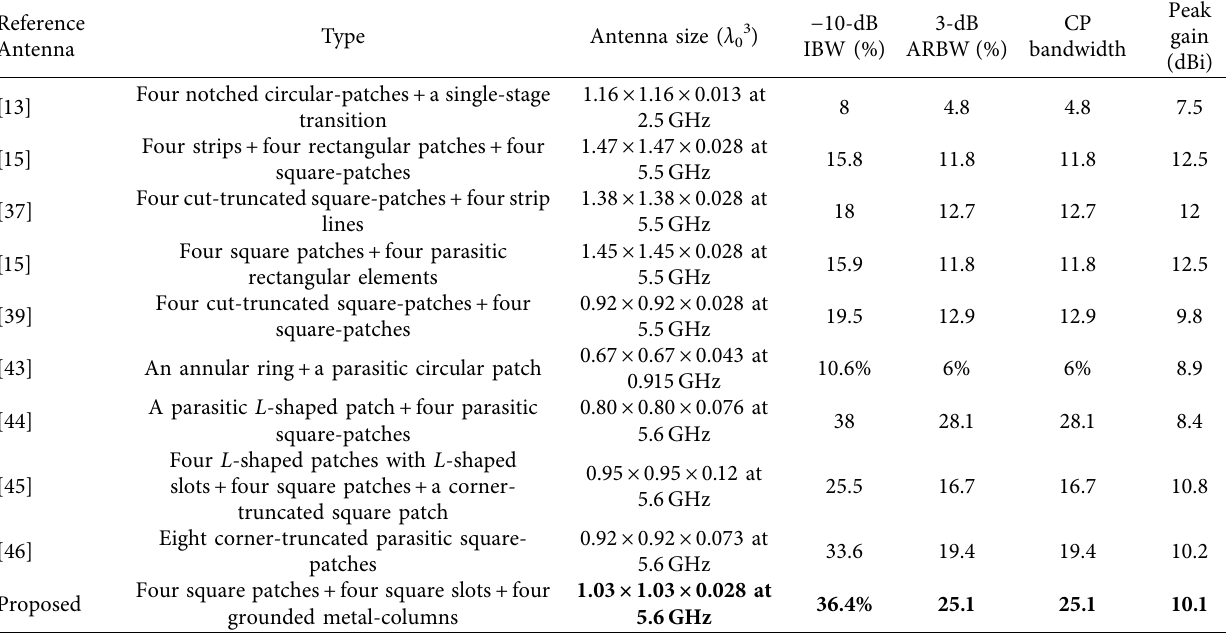
Table 2: Comparison of the designed antenna with previously reported antenna. Reference